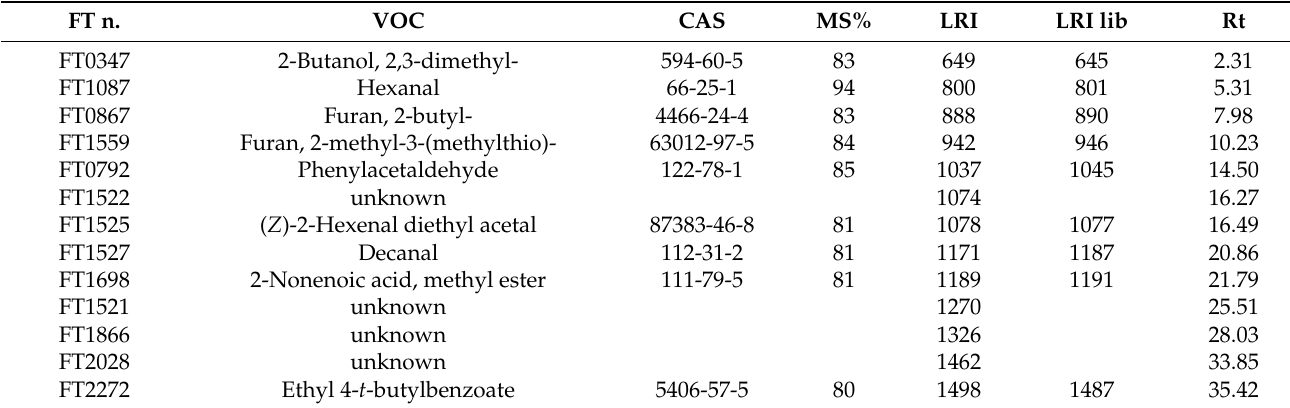
Table 1. Panel of 13 discriminatory features of seven mycobacteria species after random forest data reduction. Number of features, chemical name, CAS number, MS similarity (%), LRI calculated, LRI in NIST library (LRI lib) and retention time (Rt) are also